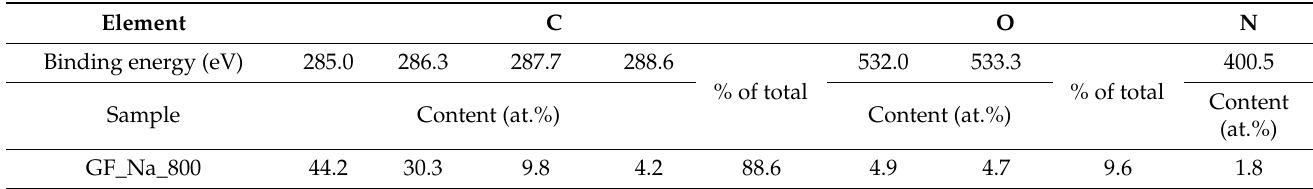
Table 2. The elemental composition of the obtained representative GF_Na_800 sample using XPS measurements.